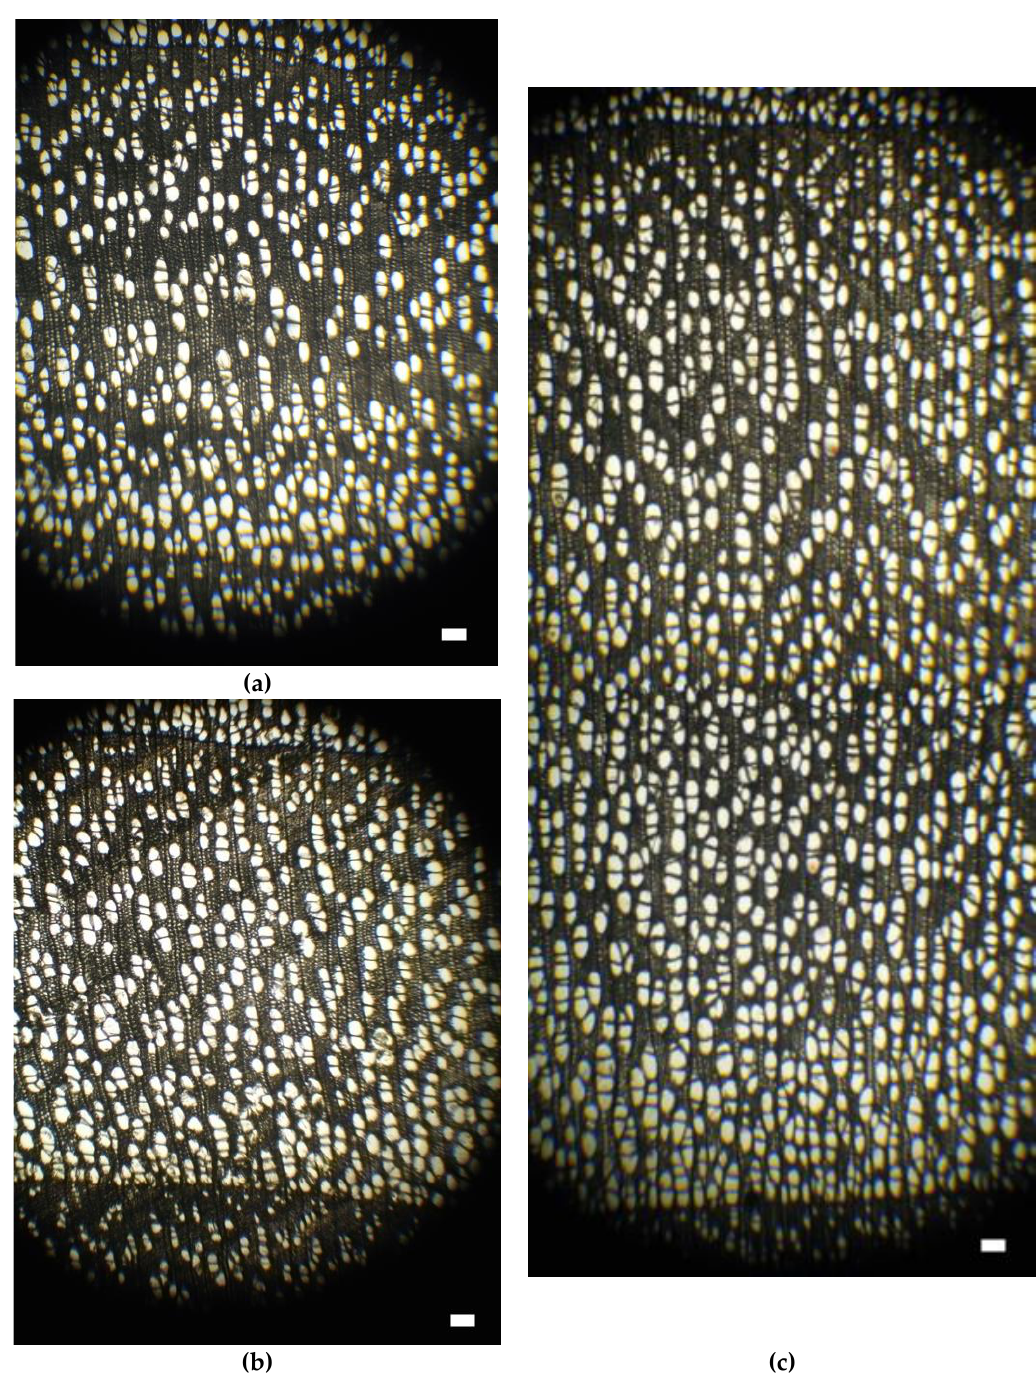
Figure 3. OBM micrographs of aspen ( Populus tremula L., × 4) on transverse section of small clear specimen, cut out from disc at a height of 1 ( a ), 5 ( b ) and 9 ( c ) meters from the stem base. Scale bars = 100 µm.